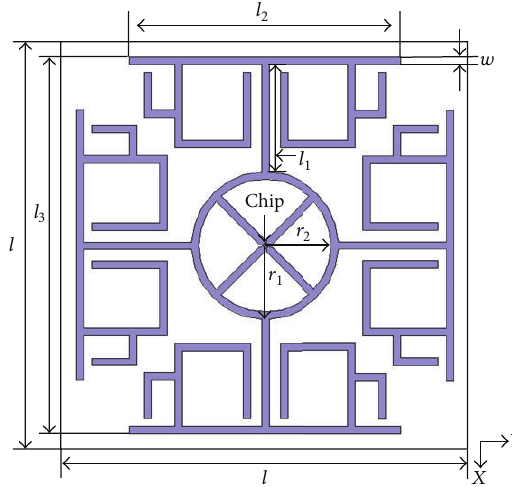
Figure 3: Structure of the linear dual-dipole tag antenna. The substrate of the antenna is made of PTFE, with an area of 𝑙 × 𝑙 and a thickness of ℎ .